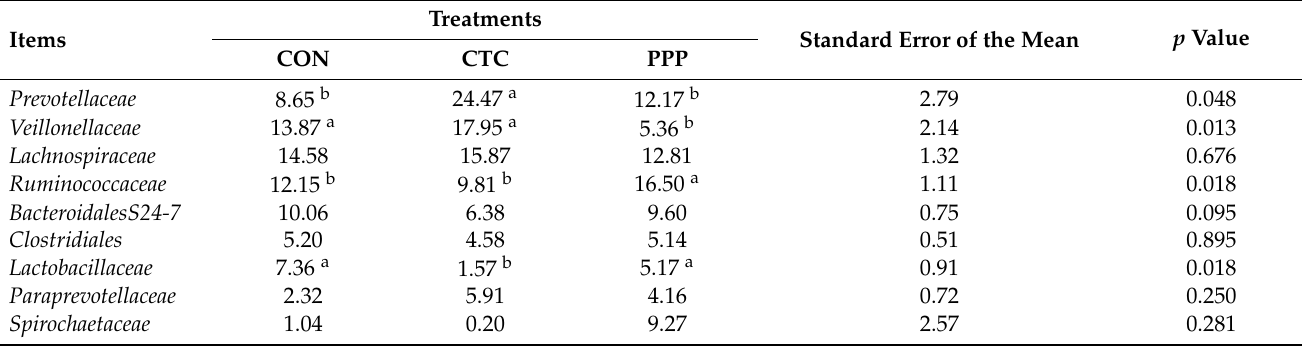
Table 7. Dietary pomelo peel powder affected the colonic microflora relative abundance at family level